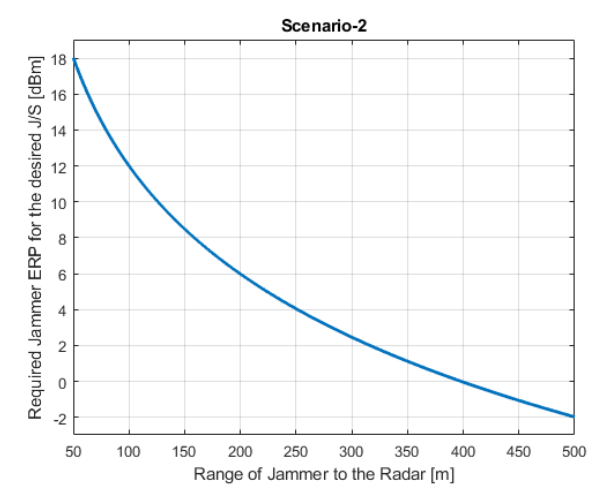
Figure 6. (Scenario-2) Jammer ERP versus range of the jammer where jammer is on the target object and applying RVGPO/I.